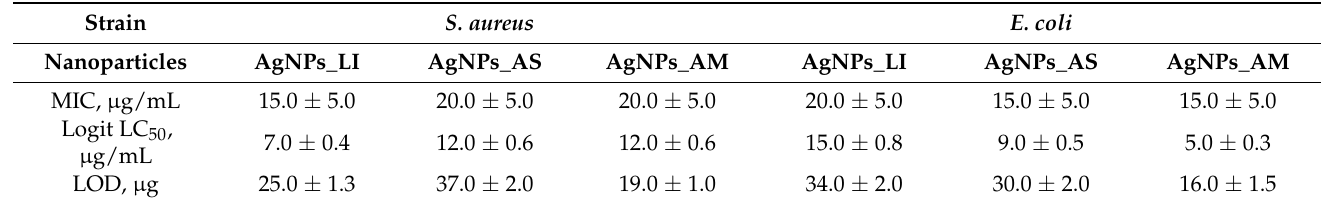
Table 3. Minimal inhibitory concentrations (MICs), Logit LC 50 (lethal concentration) model values, and LOD (limit of detection model) from a diffusion test as antimicrobial characteristics of